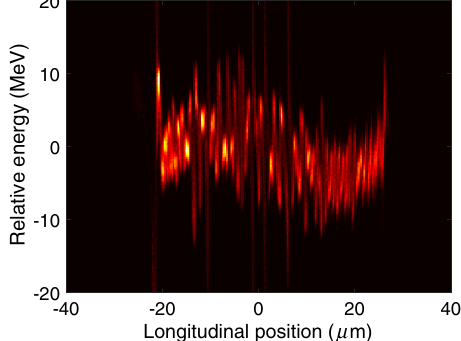
FIG. 15. Final longitudinal phase space distribution from the simulation with laser heater at 3 keV. This is to compare with Fig. 5(b) where the laser heater was off. A stronger micro- bunching effect is observed with very small